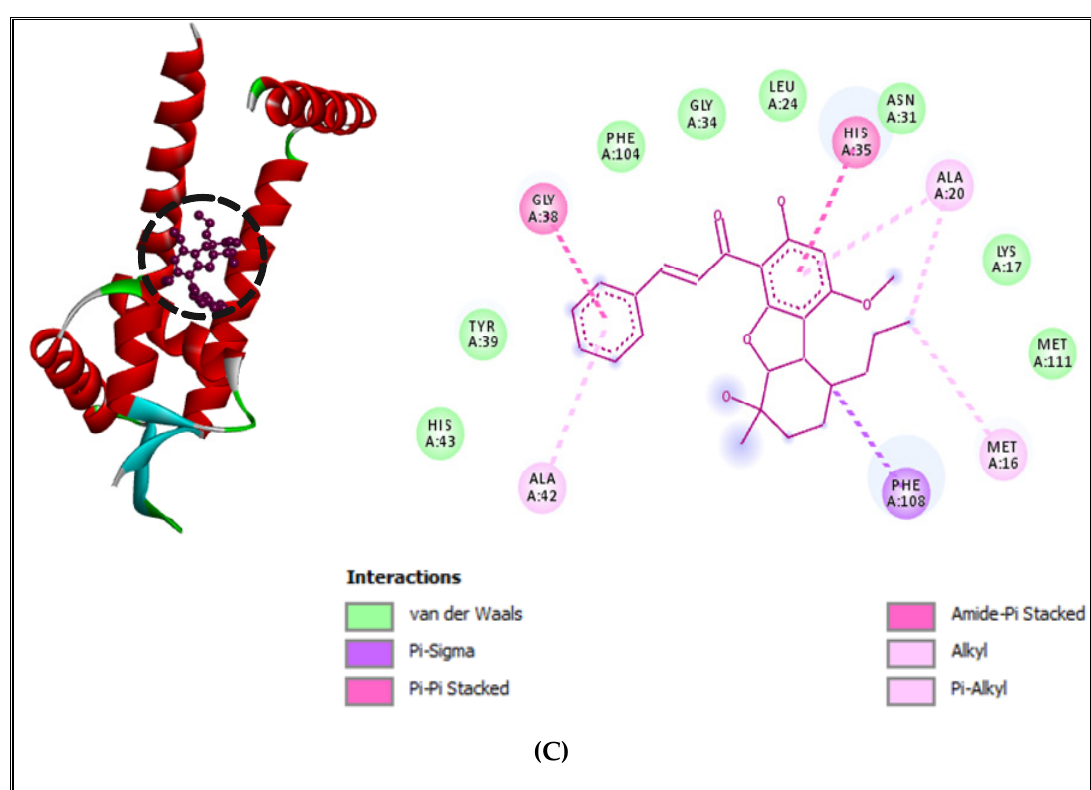
Figure 3. MepR receptor of S. aureus complexed with α -pinene ( A ), δ -3-carene ( B ), and borneol ( C ).